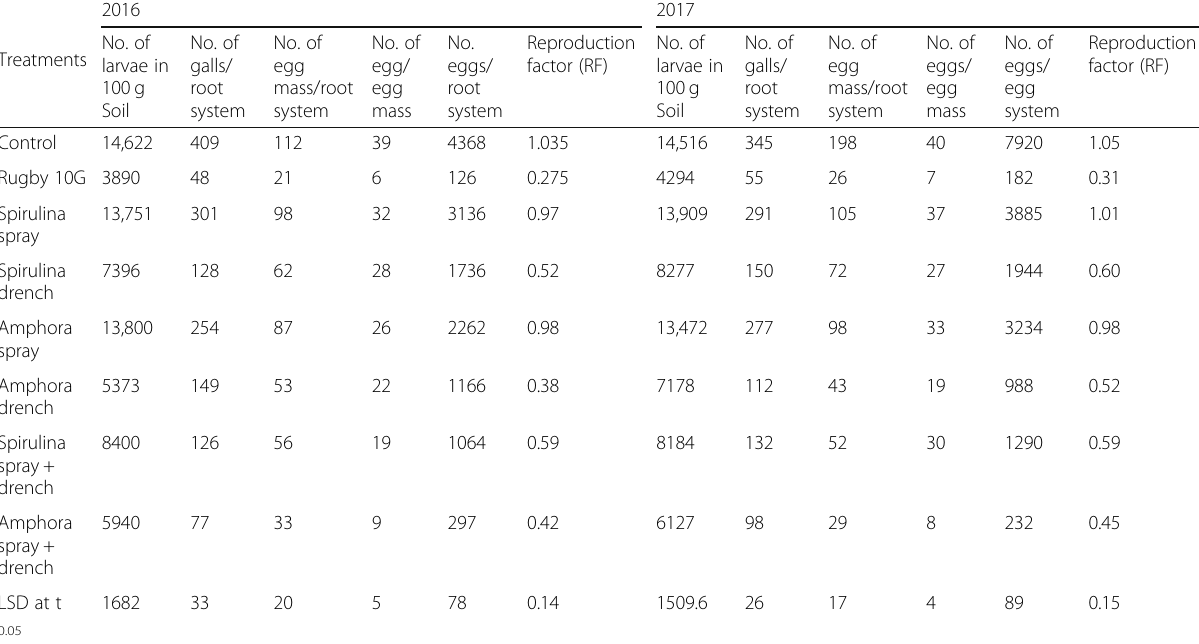
Table 5 Effect of algal treatments of cucumber Hesham hybrid compared with control and Rugby nematicide on the galls, egg masses, eggs, rate of buildup, and number of larvae in infested soil with root-knot nematodes in 2016 and 2017 seasons